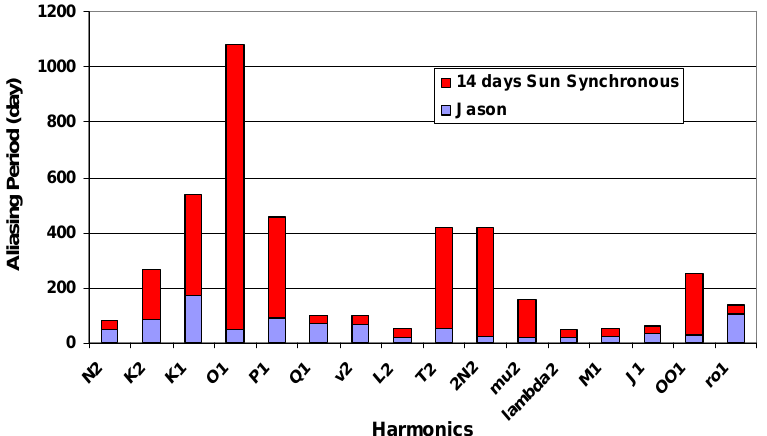
Figure 23. Tidal aliasing comparison between Jason and the proposed sun synchronous 14-day cycle. The 9.9156 solar day repeat period of T/P and Jason was chosen to minimize the effects of tidal aliasing (see [29]). One drawback of a 14-day sun-synchronous orbit may lie in the large